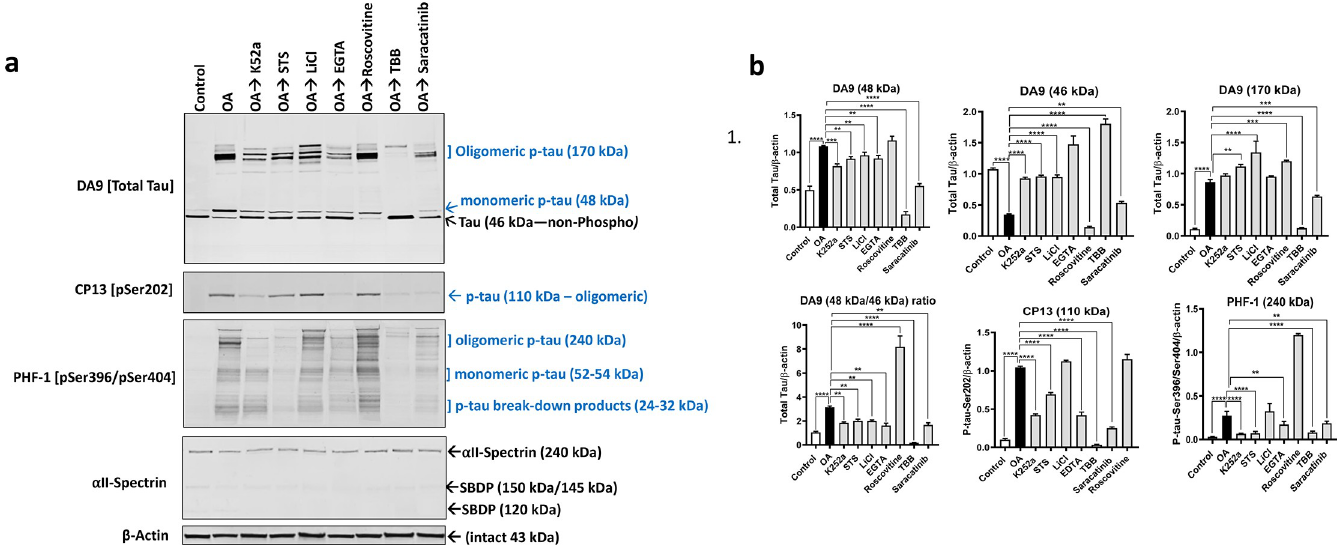
Fig 2. Screening of protein kinase inhibitors on OA-induced Tau hyperphosphorylation and oligomerization in N2a cells. (a). Immunoblots of N2a cells extracted protein (20 μ g) using phospho-tau antibodies (CP13, PHF-1), total tau (DA9), and α II-Spectrin. α II-Spectrin was probed to assess neuronal cell injury monitored with SBDP145/150 and SBDP120. Kinase inhibitors effect on OA-induced tau bands (100 nM) was monitored by evaluating the levels of monomeric (48 kDa) and oligomeric p-tau immunoreactivity (110 kDa, 170 kDa, and 240 kDa; blue arrows), total tau, and non-phospho tau (46 kDa; black arrows). Phosphorylated tau break-down products are shown with PHF-1 immunoblot. For all experimental conditions, S (a calpain inhibitor) and Z (a caspase-3 inhibitor) were added for 1h to before the addition of OA for 24h followed by 6h incubation with the kinase inhibitors. The concentrations used for each protein kinase inhibitor are mentioned in materials and methods, cell treatment section. β -actin was probed as a loading control. All experimental conditions were collected and analyzed at the same time. (b). Immunoblots quantification. All data are normalized to β -actin and are expressed as a percentage of control. Data are presented as ± SEM for n = 3. Statistical analysis was performed with one-way ANOVA. For multiple comparisons, one-way ANOVA followed by Bonferroni’s post-hoc test was performed. � p < 0.05, �� p < 0.01, ��� p < 0.001, ���� p < 0.0001 and ns: non-significant. https://doi.org/10.1371/journal.pone.0224952.g002 fully inhibited the formation of 240 kDa (HMW bands-oligomeric tau) ( Fig 2A and 2B, Table 3 ). As a selective casein kinase II (CKII) inhibitor, TBB showed robustness in inhibiting both OA-induced tau hyperphosphorylation and oligomerization. Thus, the aim was to evalu- ate the TBB dose-response effect on N2a neuronal culture. Thus, N2a cells were treated with OA for 24h followed by treatment with various concentrations of TBB (10 nM, 30 nM, 100